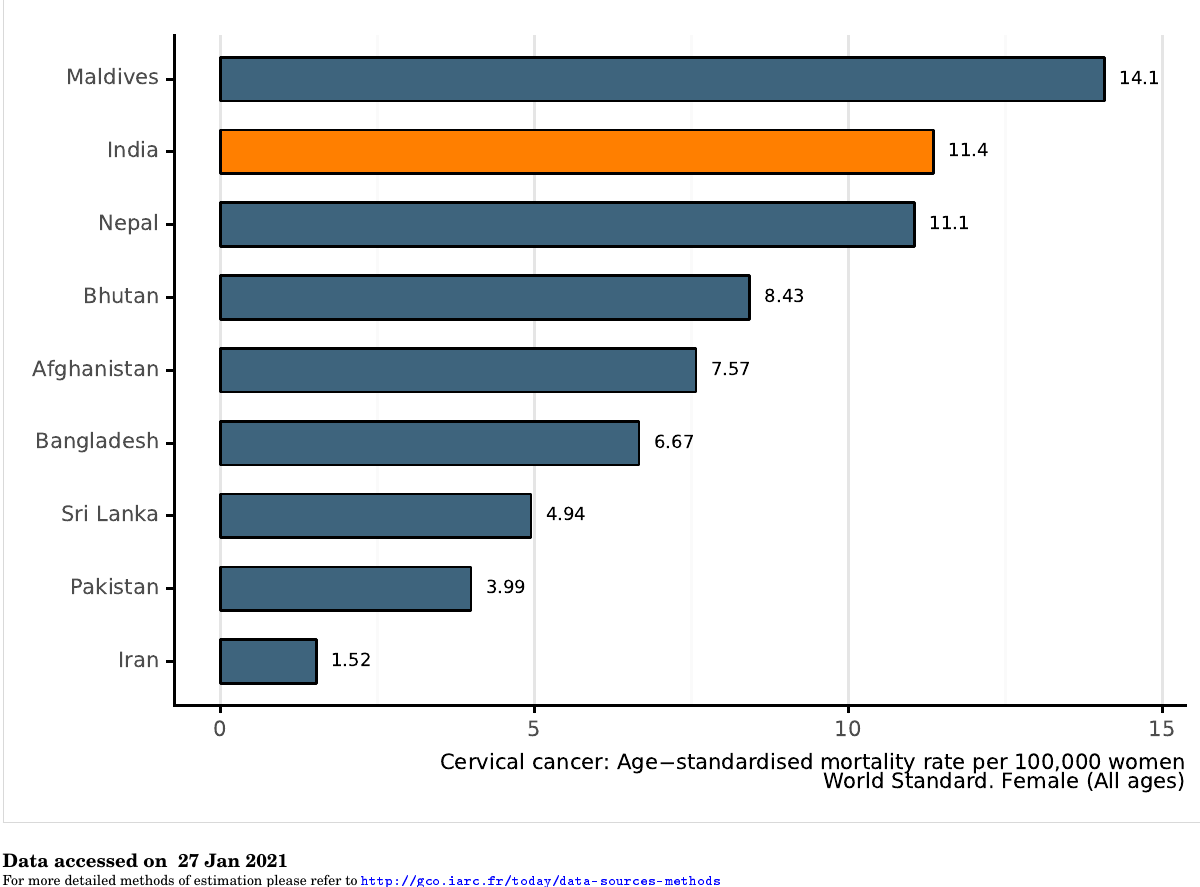
Figure 105: Age-standardised mortality rates of cervical cancer of India (estimates for 2020)